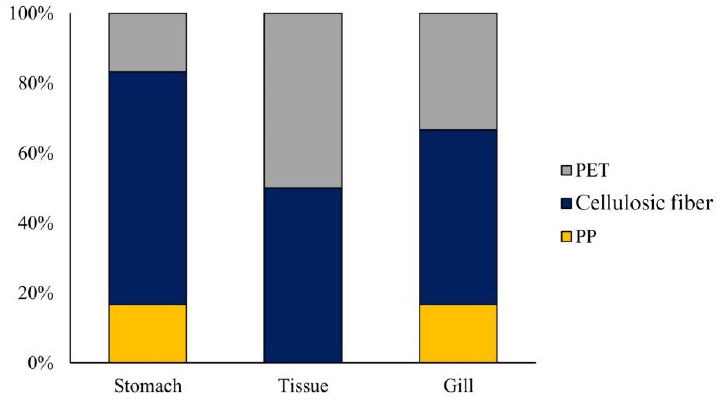
Figure 4 . The percentage of polymer type found in each organ studied in O . militaris . Figure 4. The percentage of polymer type found in each organ studied in O. militaris